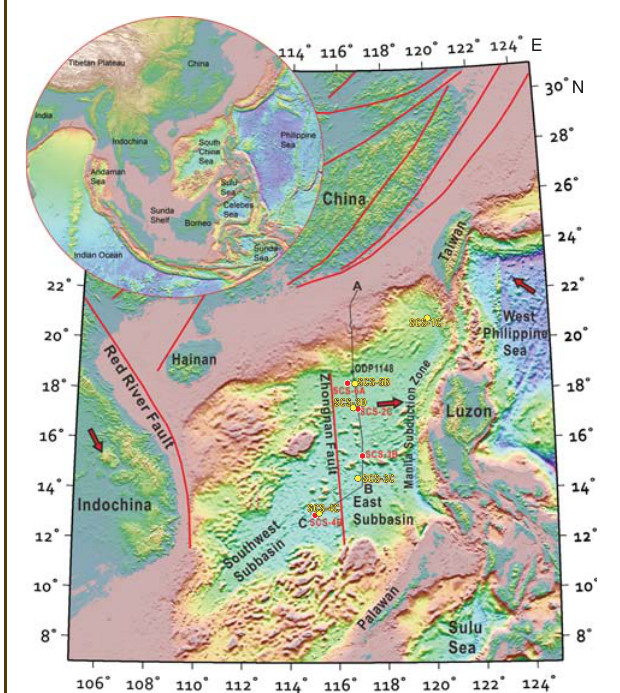
Figure 1. Regional topography and tectonic framework of Southeast Asia (from Shi and Li, 2012). Data based on Smith and Sandwell (1997). Red lines mark major faults. Red and yellow solid points are locations of the proposed drilling sites (red-primary sites; yellow- alternate sites). The black lines labeled with AB and BC are seismic sections shown in Fig. 3. Red arrows indicate the direction of plate